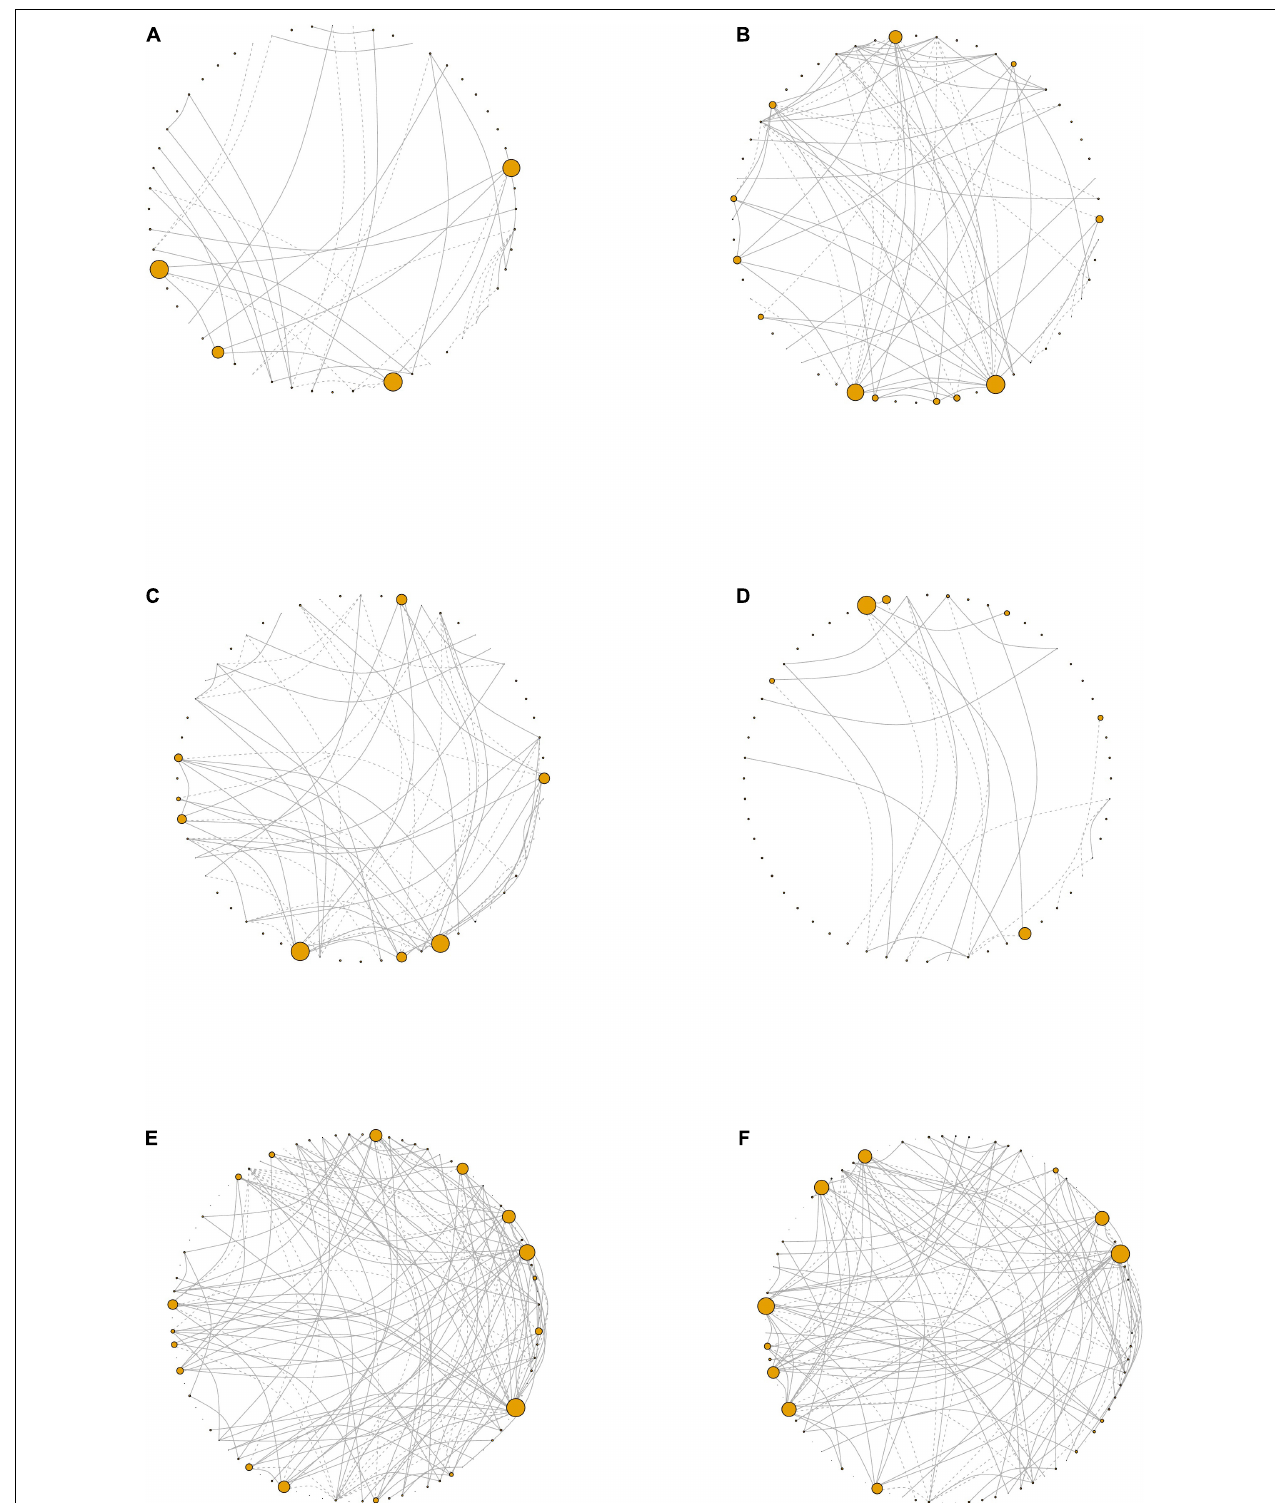
FIGURE 6 | Network visualizations. Network plots derived from the periodontal treatment (PT) study patients whose oral status was designated as (A) gingivitis, (B) moderate, (C) shallow, or (D) deep. For the sodium hypochlorite (SHT) study, network plots for biofilms from patients with (E) class “A” or (F) class “C.” Node size corresponds to eigen centrality. Dashed lines represent negative correlations and solid lines represent positive correlations.